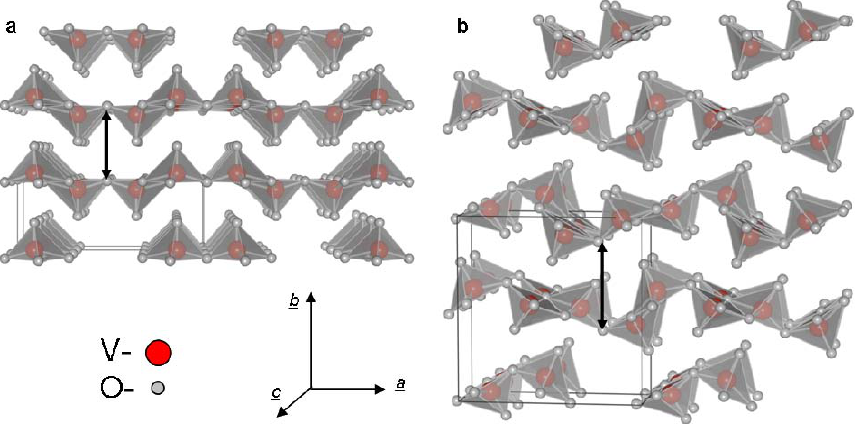
Figure 1. Crystal structures of (a) α -V c = 3.56 Å; a = 9.94 Å, b = 10.04 Å and c = 3.58 Å, respectively). Black arrows mark the vdW